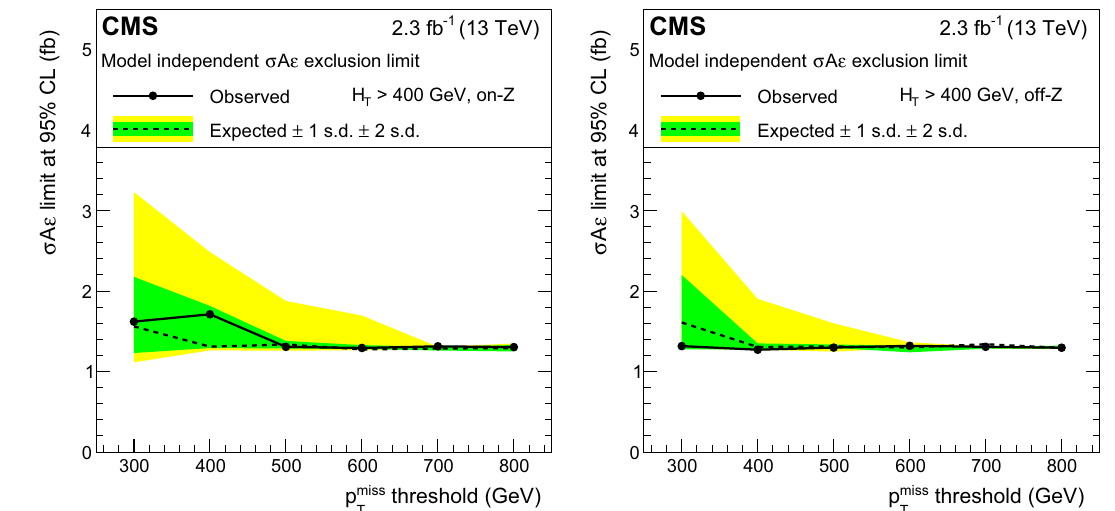
Fig. 5 Limits on the product of cross section, detector acceptance, and selection efficiency, σ A (cid:11) , for the production of multilepton events with (left) or without (right) an on-Z lepton pair as a function of the p miss T